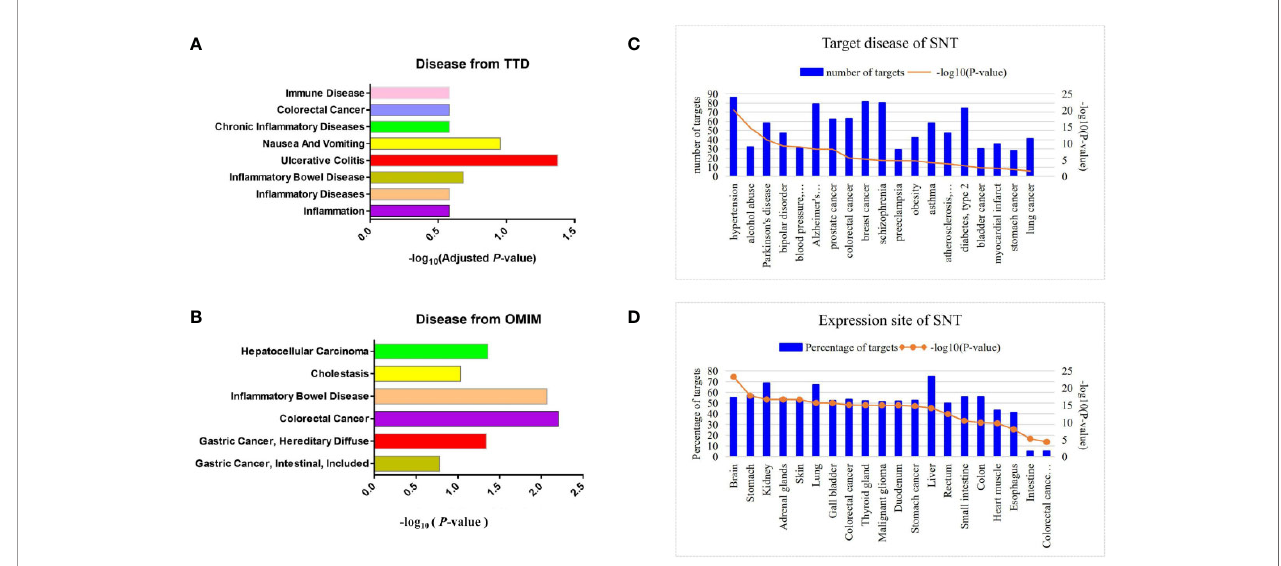
FIGURE 1 | Prediction of disease and tissue targets of SNT. Predicted disease targets of SNT (related to the digestive system) based on the (A) TTD, (B) OMIM, and (C) DAVID analyses. (D) Tissue-speci fi c distribution of potential targets of